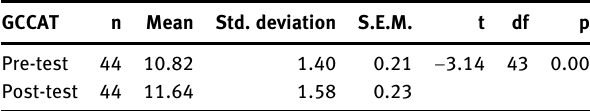
Table  : Paired-samples t-test results for GCCA pre-test and post- test scores. GCCAT